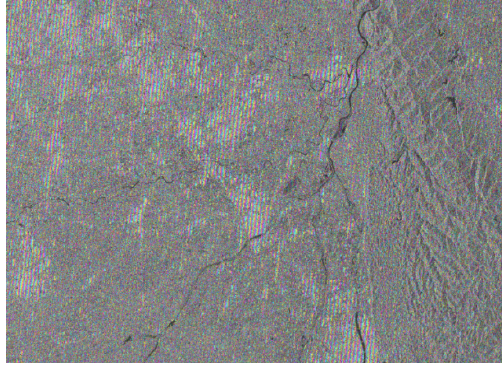
Figure 9. Sentinel-1 interferogram.